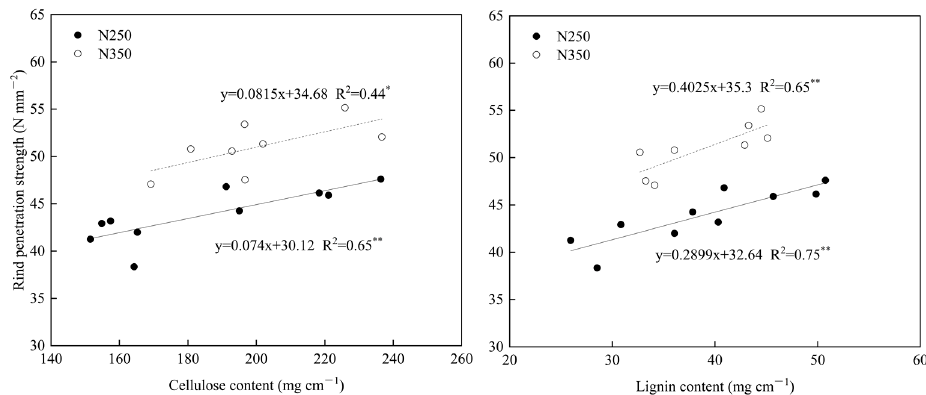
Figure 6. Relationship between the rind penetration strength, cellulose, and lignin contents of the third elongation internode under different nitrogen application rates. N250 and N350 refer to the nitrogen application rate being 250 and 350 kg ha − 1 , respectively. * and ** represent significant correlations between the levels of p = 0.05 and p = 0.01, respectively.